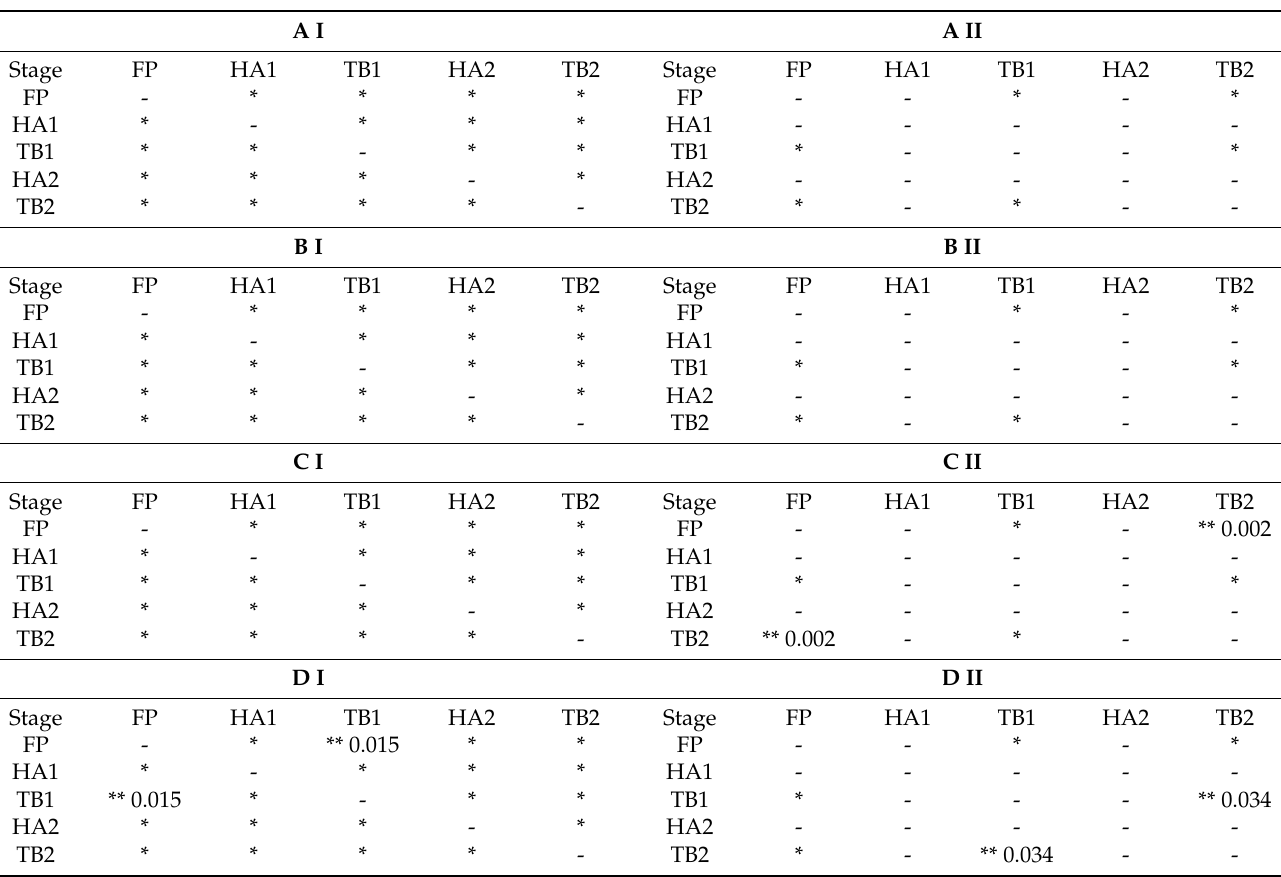
Table 3. Differences between the subgroups in each